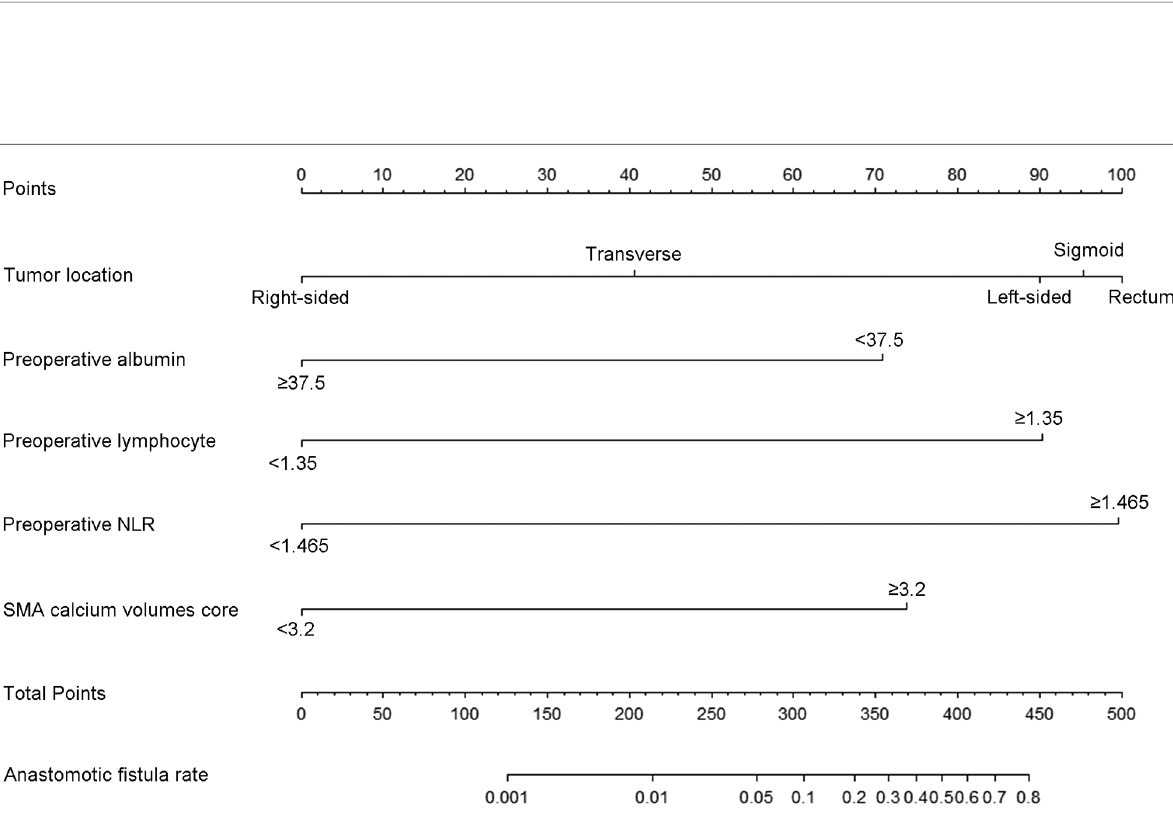
FIGURE 4 The nomogram predicting postoperative AL in patients with colorectal adenocarcinoma. Match the characteristics of patients to the scale of each risk factor in the nomogram to get the corresponding points. All points were added up to obtain the total points, and then total points was matched to the scale of anastomotic fi stula rate to obtain the probability of AL. NLR, neutrophil-lymphocyte